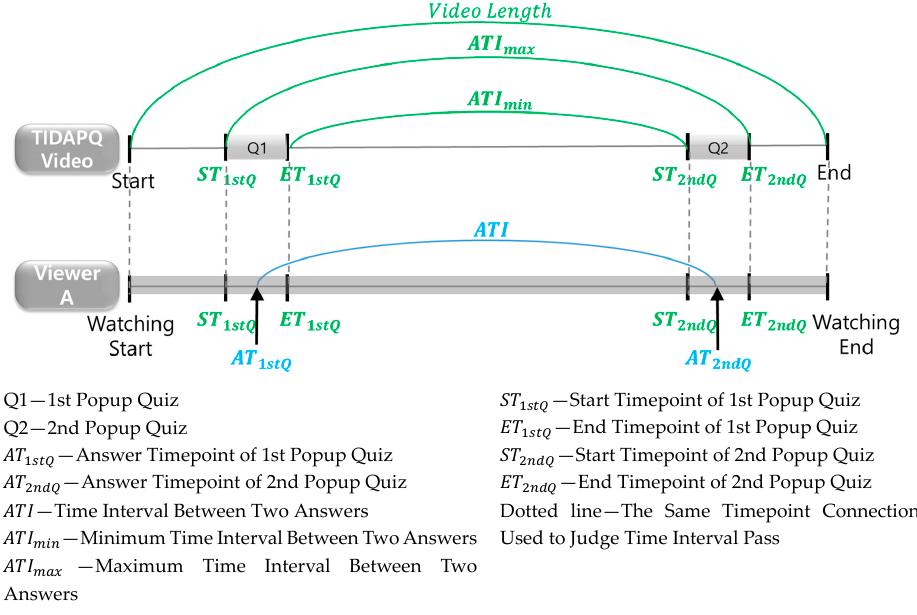
Figure 7. TIDAPQ Video Time Flow and Viewer A’s Time Interval Pass Process.